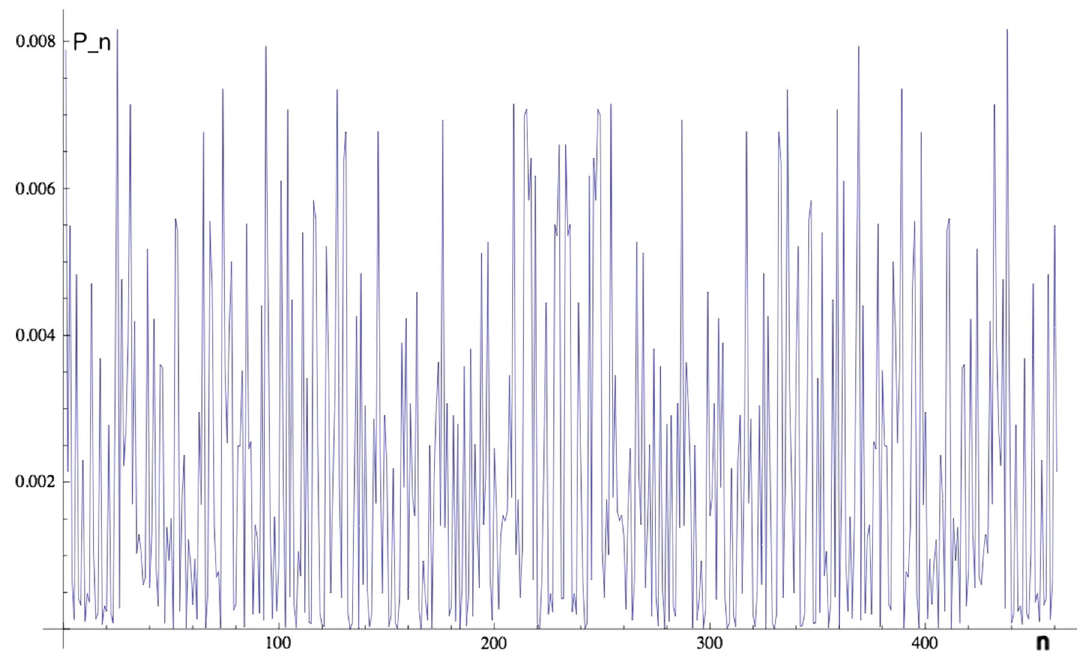
Fig. 4 Thesquaredamplitude, P n ≡ | a n | 2 ,vs.thecomponentlabel,0 ≤ n ≤ p − 1,inthesymmetricgroundstate(inthesubspaceofdimensionality ( p − 1 )/ 2) of the quantum Arnol’d cat map, for p =